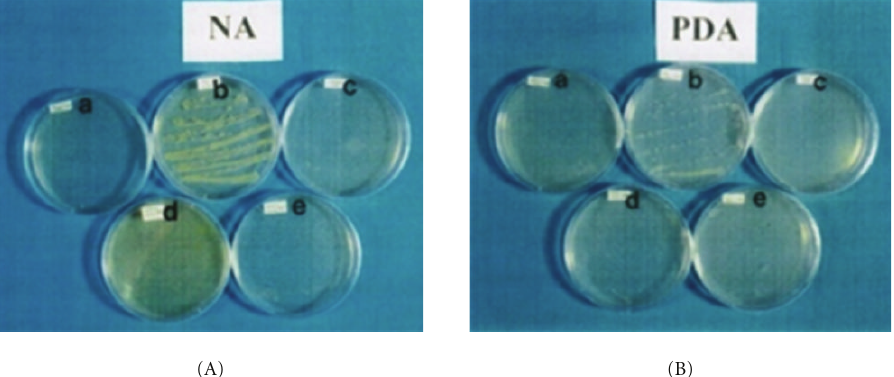
Figure 6: Growth of bacteria and fungi on (A) nutrient agar and (B) potato dextrose agar media plated on petri dish which contain copper coin (a), tap water (b), 8-HQC (c), P. betle leaf extract (d), and P. guajava leaf extract (e) on both media after day 2 of streaking vase solution of cut carnation flowers on day